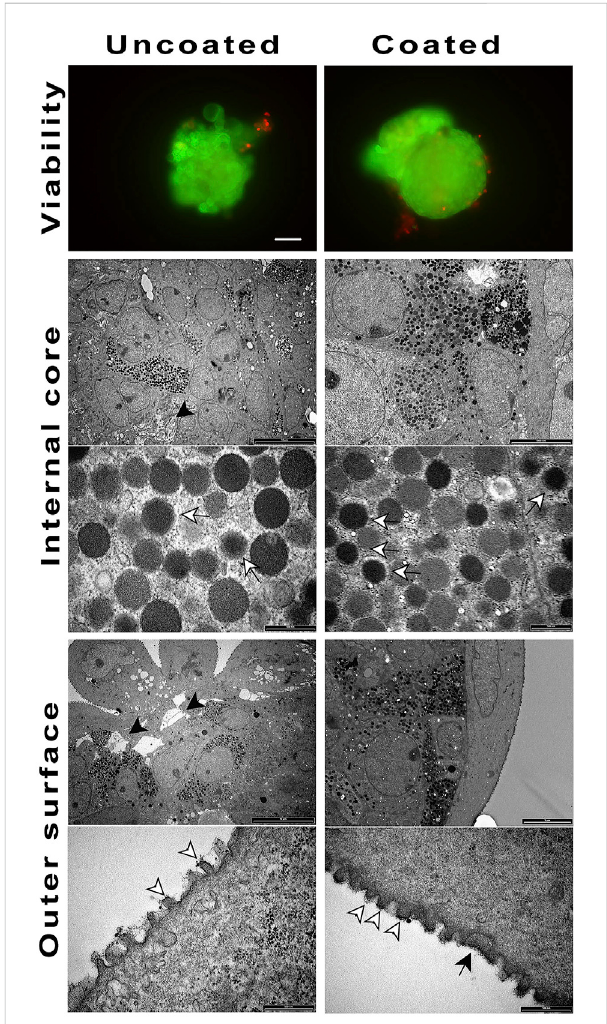
FIGURE 4 Coated and un-coated cell spheroids transplanted at Div27 in NOD/SCID mice and retrieved 14 days later. Viability was maintained with the un-coated cell spheroids looking inhomogeneous (black arrow heads) as compared to the coated ones (20X). TEM examination of the inner core showed the presence of hormone granules in both samples (white arrows). ELRs coating was still detectable on the outer spheroids surface (black arrow). White arrowheads showed membrane